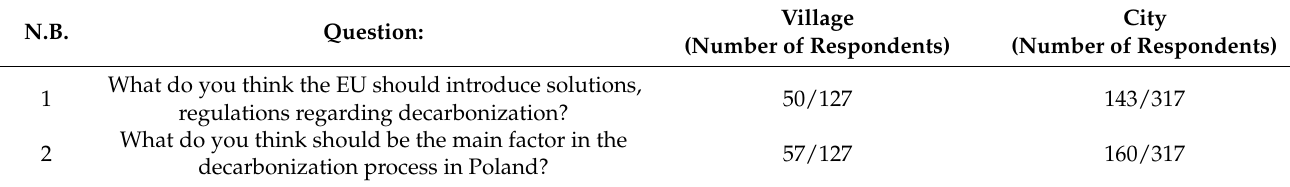
Table 6. List of answers for two questions.